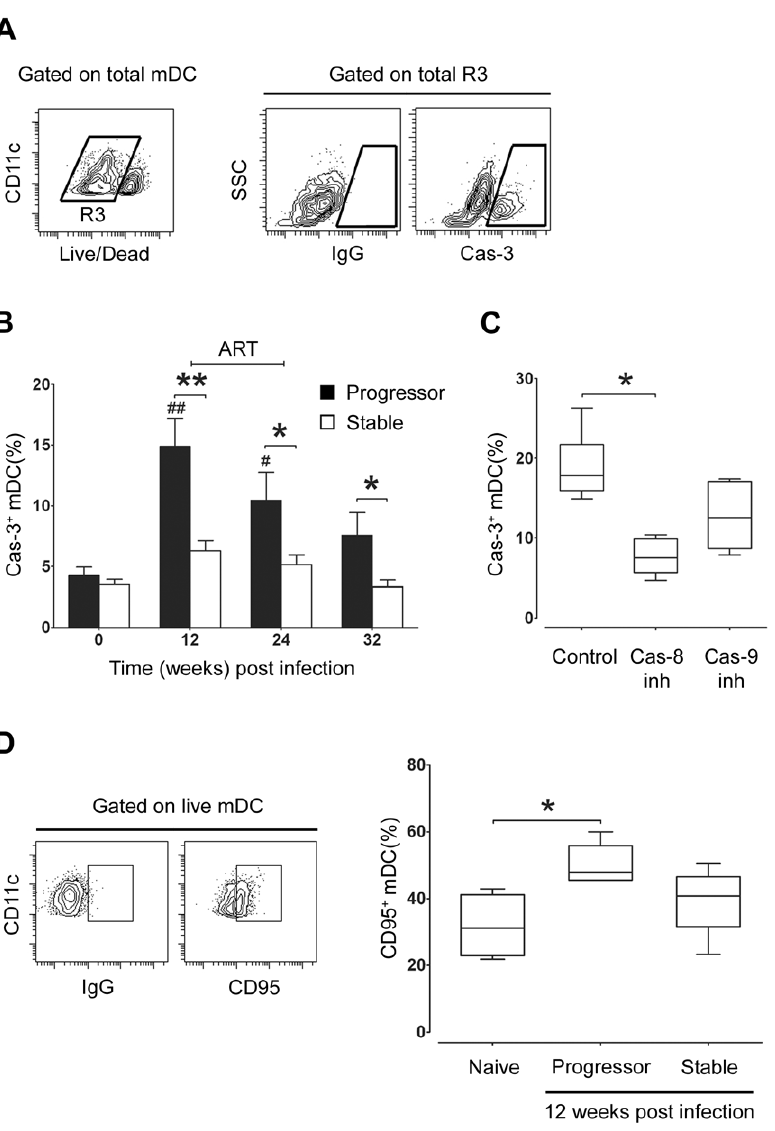
Figure 5. Apoptosis of lymph node mDC increases in progressive but not stable SIV infection. (A) Representative flow cytometry plots showing the gating strategy used to identify mDC expressing active caspase-3 (Cas-3). Live mDC were defined as Lineage 2 HLA-DR + CD11c + cells that lacked staining with a fixable dead-cell dye. (B) The proportion of lymph node mDC expressing active caspase-3 relative to staining with a control antibody at intervals before and after SIV infection. Cells were cultured for 3 hours prior to analysis. Shown are mean 6 SEM for naı¨ve (T=0, n=14), progressor (n=8) and stable n=10). (C) The proportion of lymph node mDC, taken at 12 weeks post infection from animals with progressive infection, expressing active caspase-3 after 3 hours in the presence of caspase-8 inhibitor (Cas-8 inh), caspase-9 inhibitor (Cas-9 inh) or control inhibitor (Control). Boxes represent 25 th to 75 th percentile and median values, and whiskers represent the minimum and maximum values, using data from 6 animals. (D) Left: Representative dot plots showing expression of CD95 relative to isotype control antibody to define positively staining cells. Right: The proportion of lymph node mDC at 12 weeks post infection that express CD95 in naı¨ve animals (n=4) and animals with progressive (n=5) and stable infection (n=5). Boxes represent 25 th to 75 th percentile and median values, and whiskers represent minimum and maximum values. * P , 0.05, ** P , 0.01 between groups; # P , 0.05, ## P , 0.01, within groups relative to week 0. ART=intervals of antiretroviral therapy.